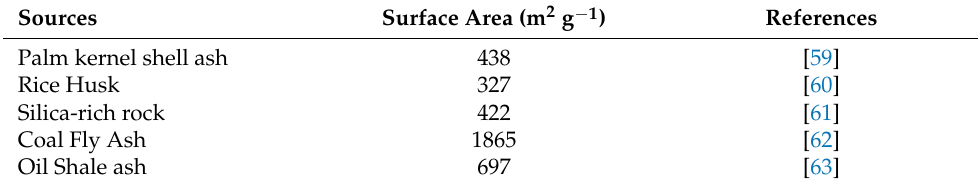
Table 2. Surface area of previously prepared nano silica.